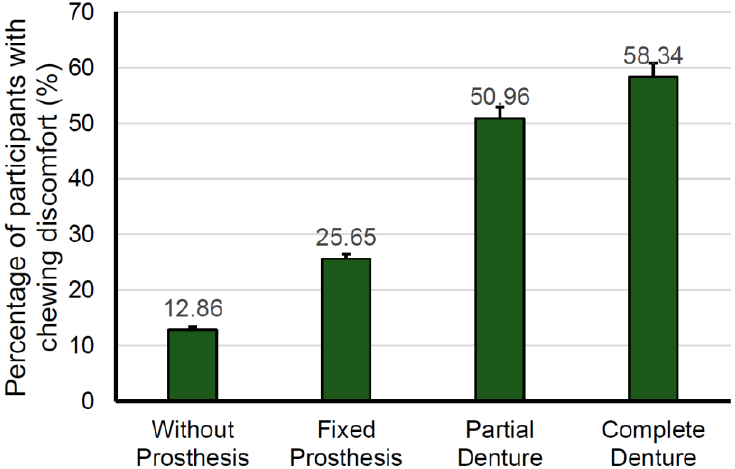
Figure 2. Percentage of participants with chewing discomfort according to dental prosthesis type ( p for trend < 0.0001).